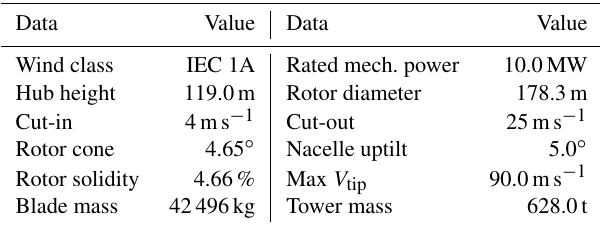
Table 6. Configuration of the 10MW offshore wind turbine.